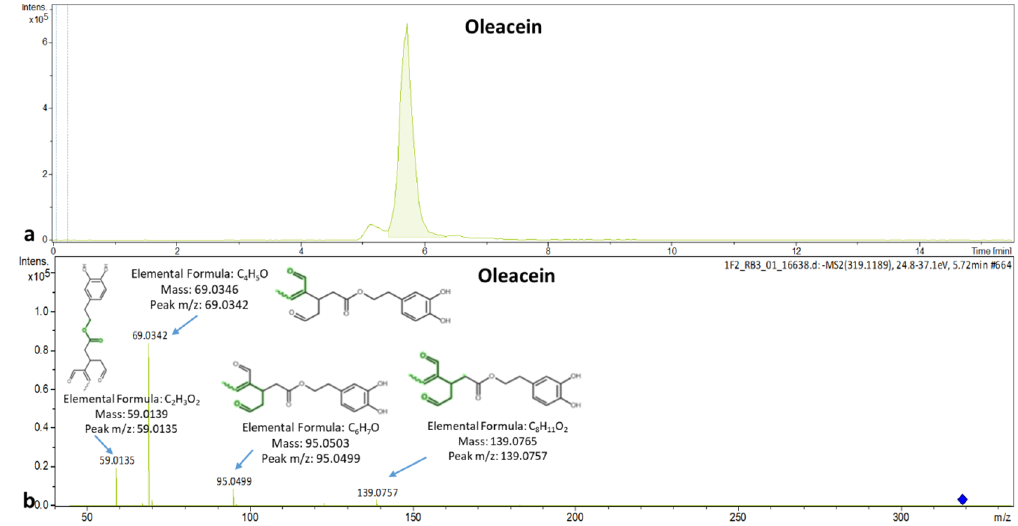
Figure 6. ( a ) Extracted ion chromatogram of oleacein in a leaf sample; ( b ) MS/MS spectrum of oleacein with explained fragments.